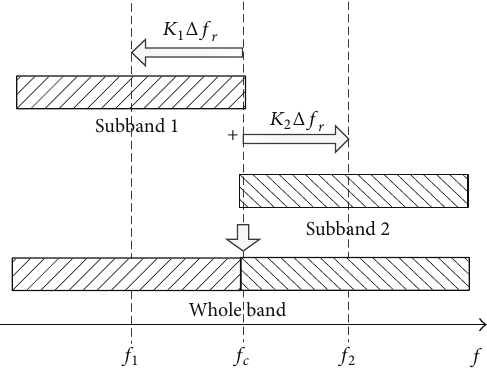
Figure 3: The spectrum shift and coherent summation ( 𝑁 = 2 ).